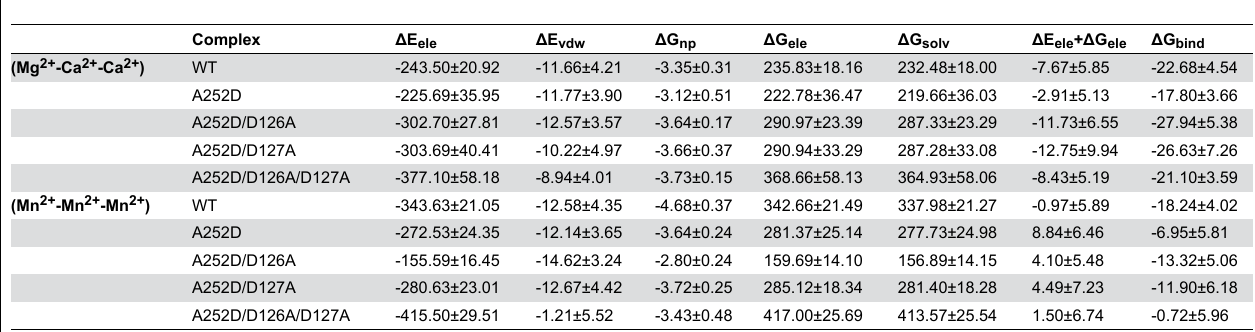
Table 1. Binding free energies computed by the MM/GBSA method (neglecting the configurational entropy, kcal/mol).